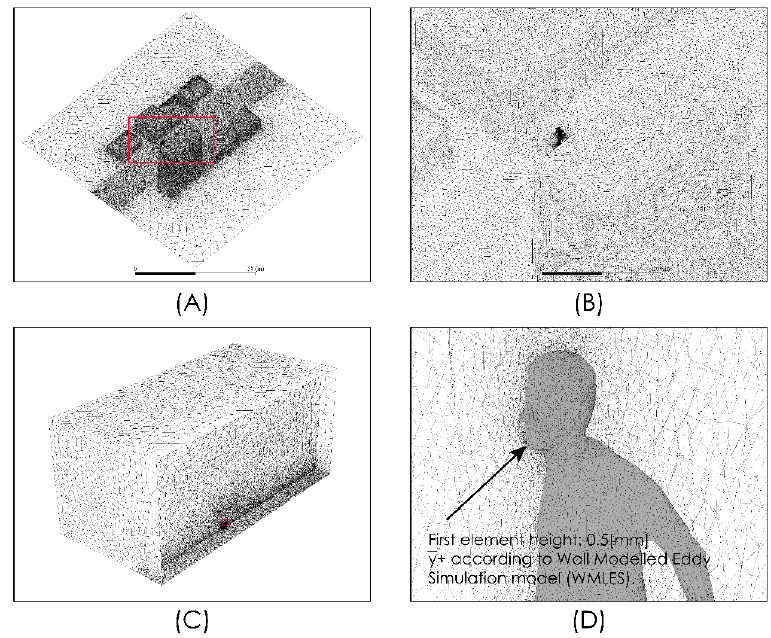
Figure 3. Domain discretization. Global views ( A – C ) and near person zone ( D ).